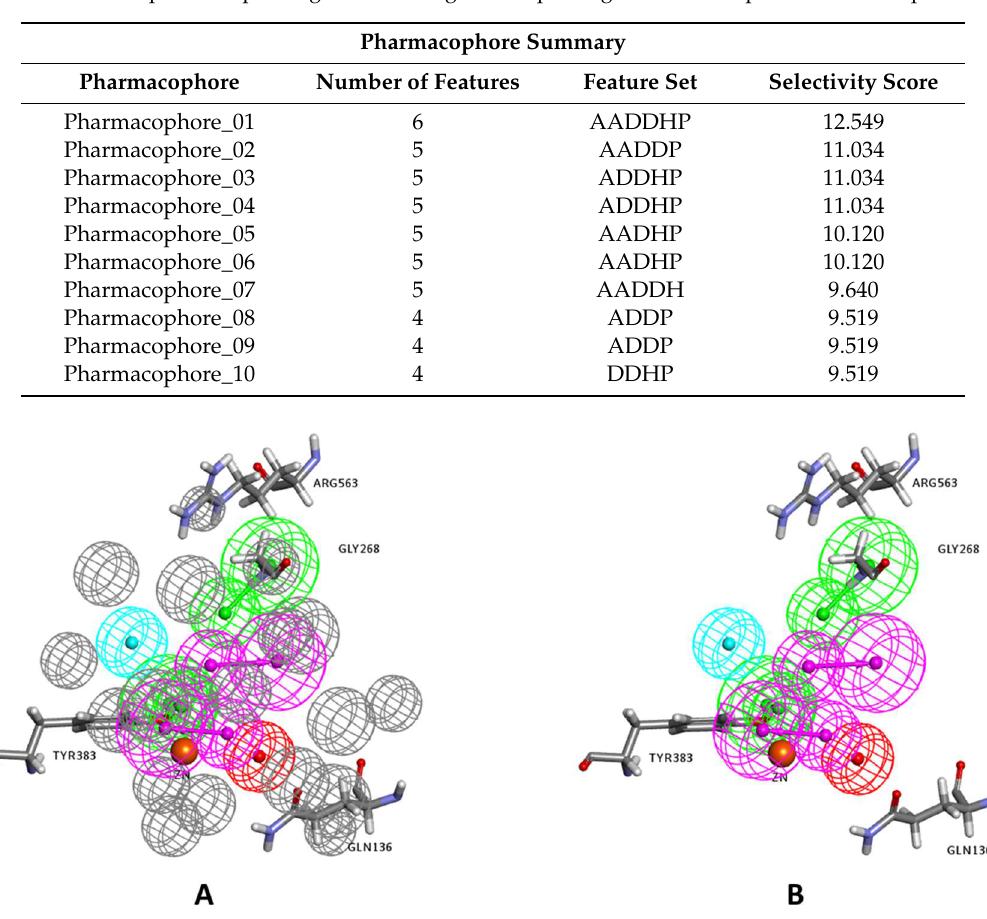
Table 1. The ten pharmacophores generated using the Receptor-Ligand Pharmacophore Generation Table 1. ThetenpharmacophoresgeneratedusingtheReceptor-LigandPharmacophoreGenerationprotocol.